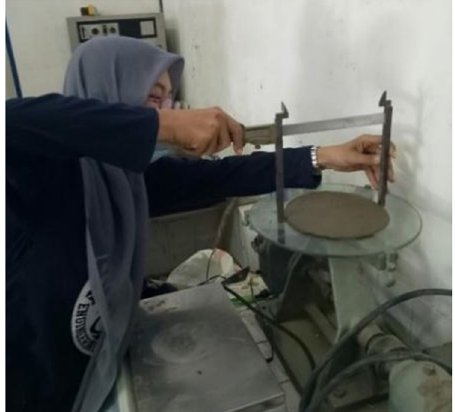
Figure 3: Flow test.